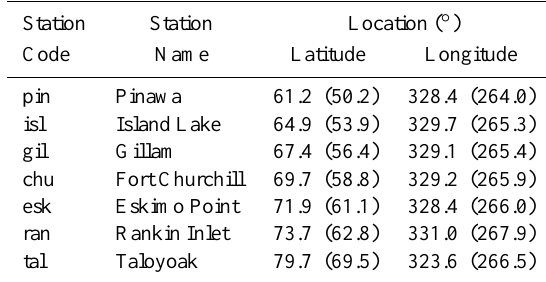
Fig. 1. Map of the CANOPUS (NORSTAR) magnetometer (riome- ter) array along with contours of constant geomagnetic (PACE) lat- itude and longitude. Table 1. PACE geomagnetic and geodetic (in brackets) coordinates for the CANOPUS (NORSTAR) Churchill line magnetometer (ri- ometer)